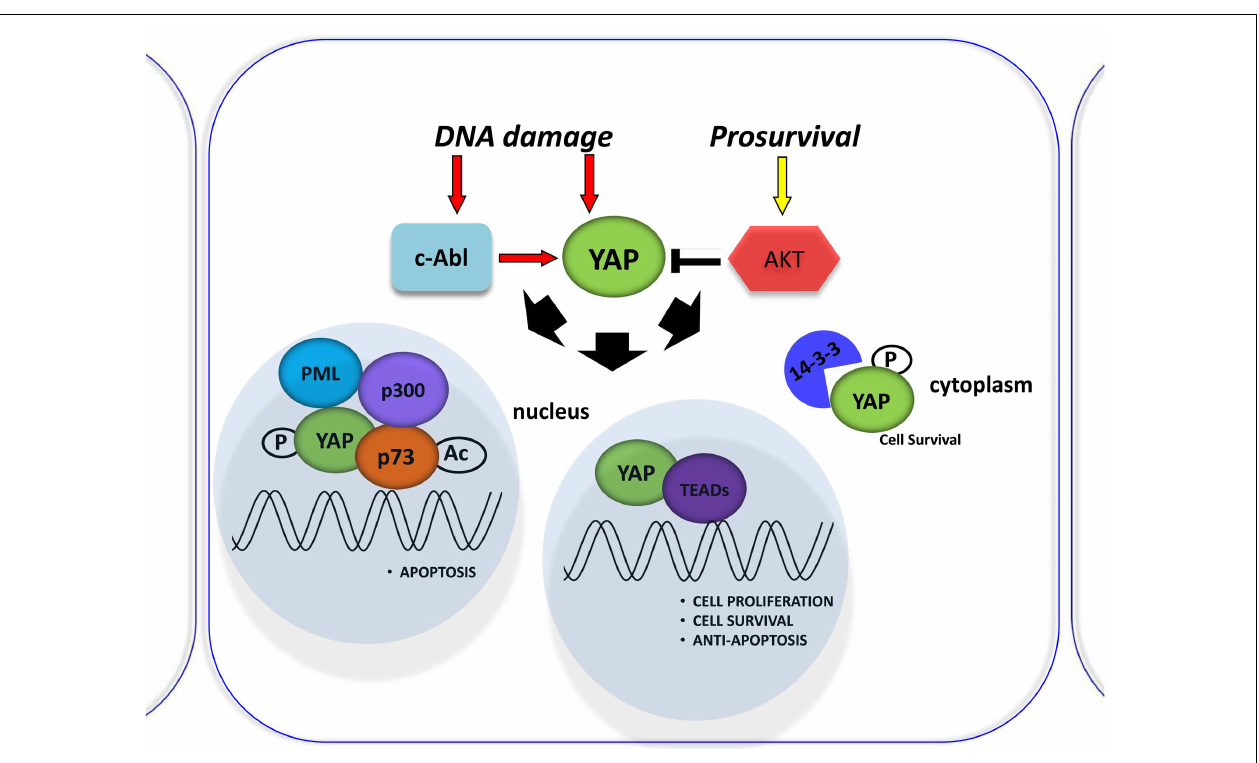
resulting inYAP nuclear localization and increased p73 binding and activation of pro-apoptotic genes. By contrast, active Akt counters this effect by phosphorylatingYAP and sequestering it at the cytoplasmic